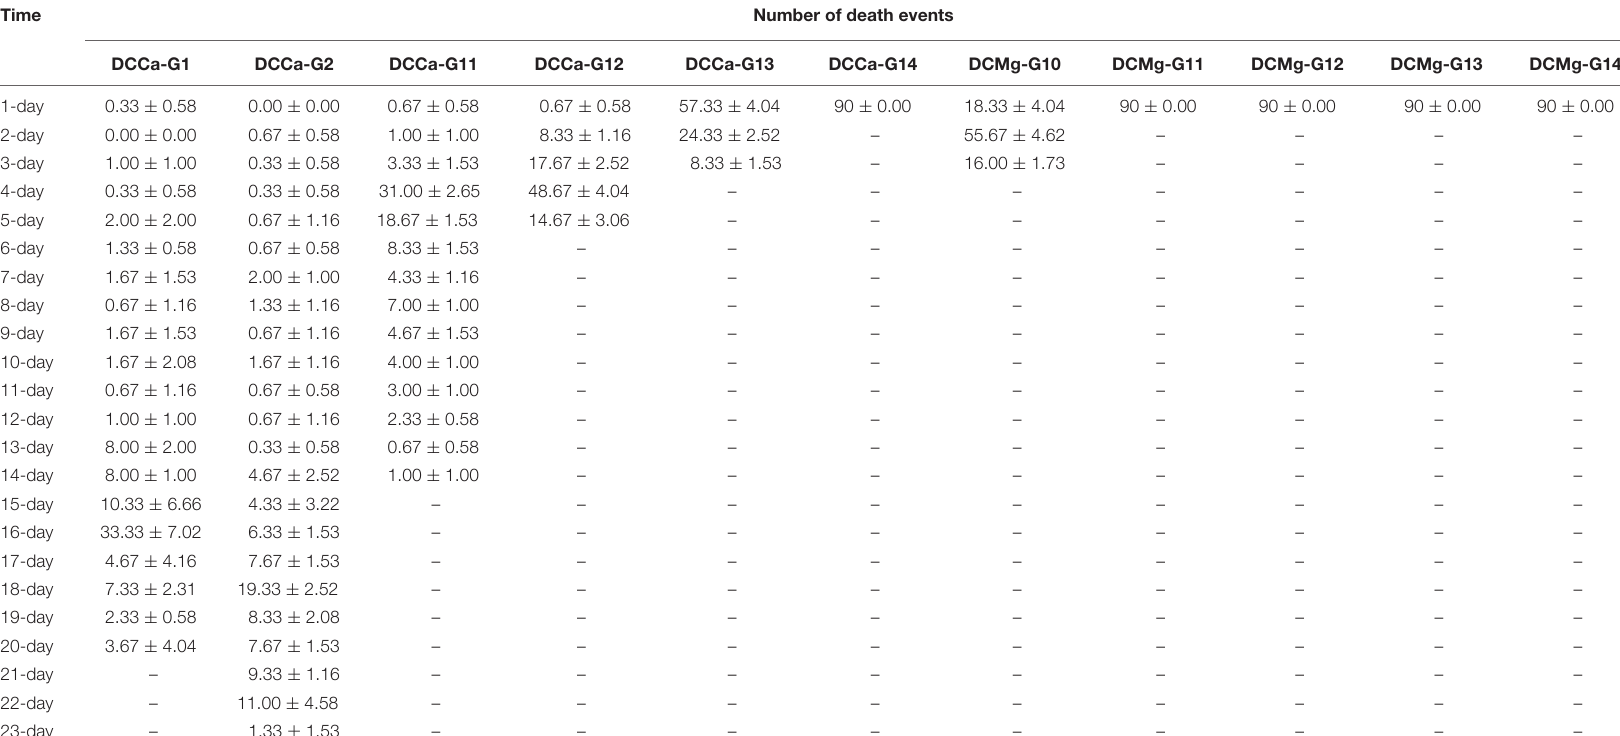
TABLE 2 | Detailed juvenile Sinonovacula constricta mortality information in the test groups which cannot survive under long-term stress with different Ca 2 + and Mg 2 + concentrations.